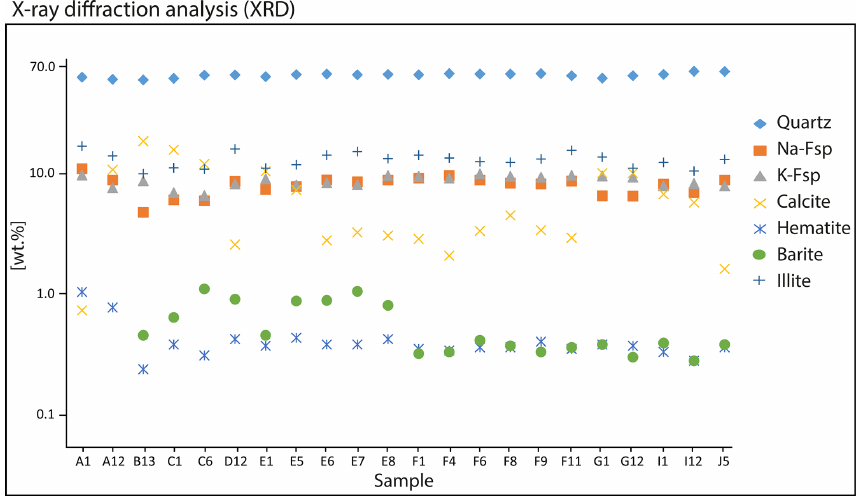
Figure 2. XRD analysis of the main minerals in the plugs based on Rietveld calculations, determined for several samples of facies A to J of the sandstone